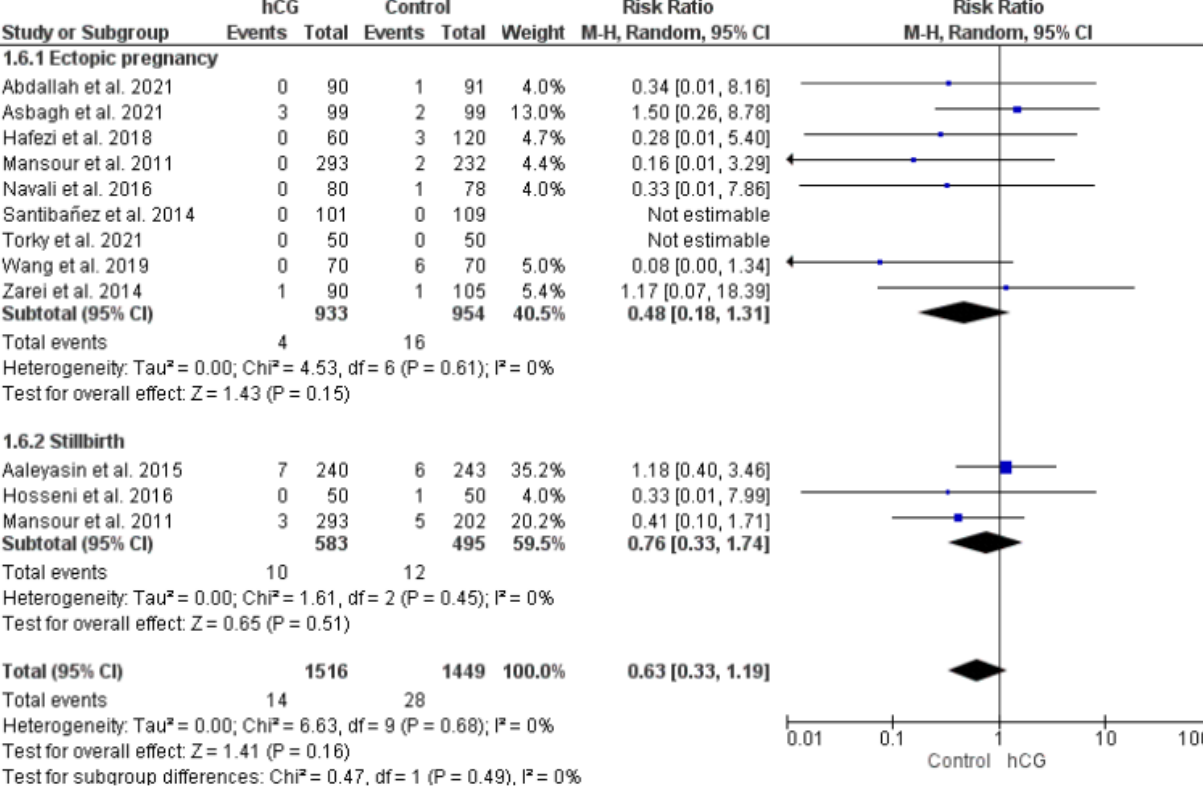
Figure 6. Forest plot showing the effect of intrauterine hCG injection versus control group on adverse events (ectopic pregnancy, stillbirth).